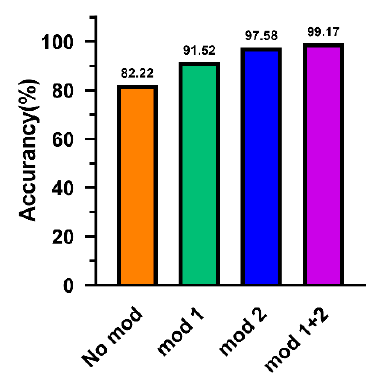
Figure 9. The results of ablation experiments.